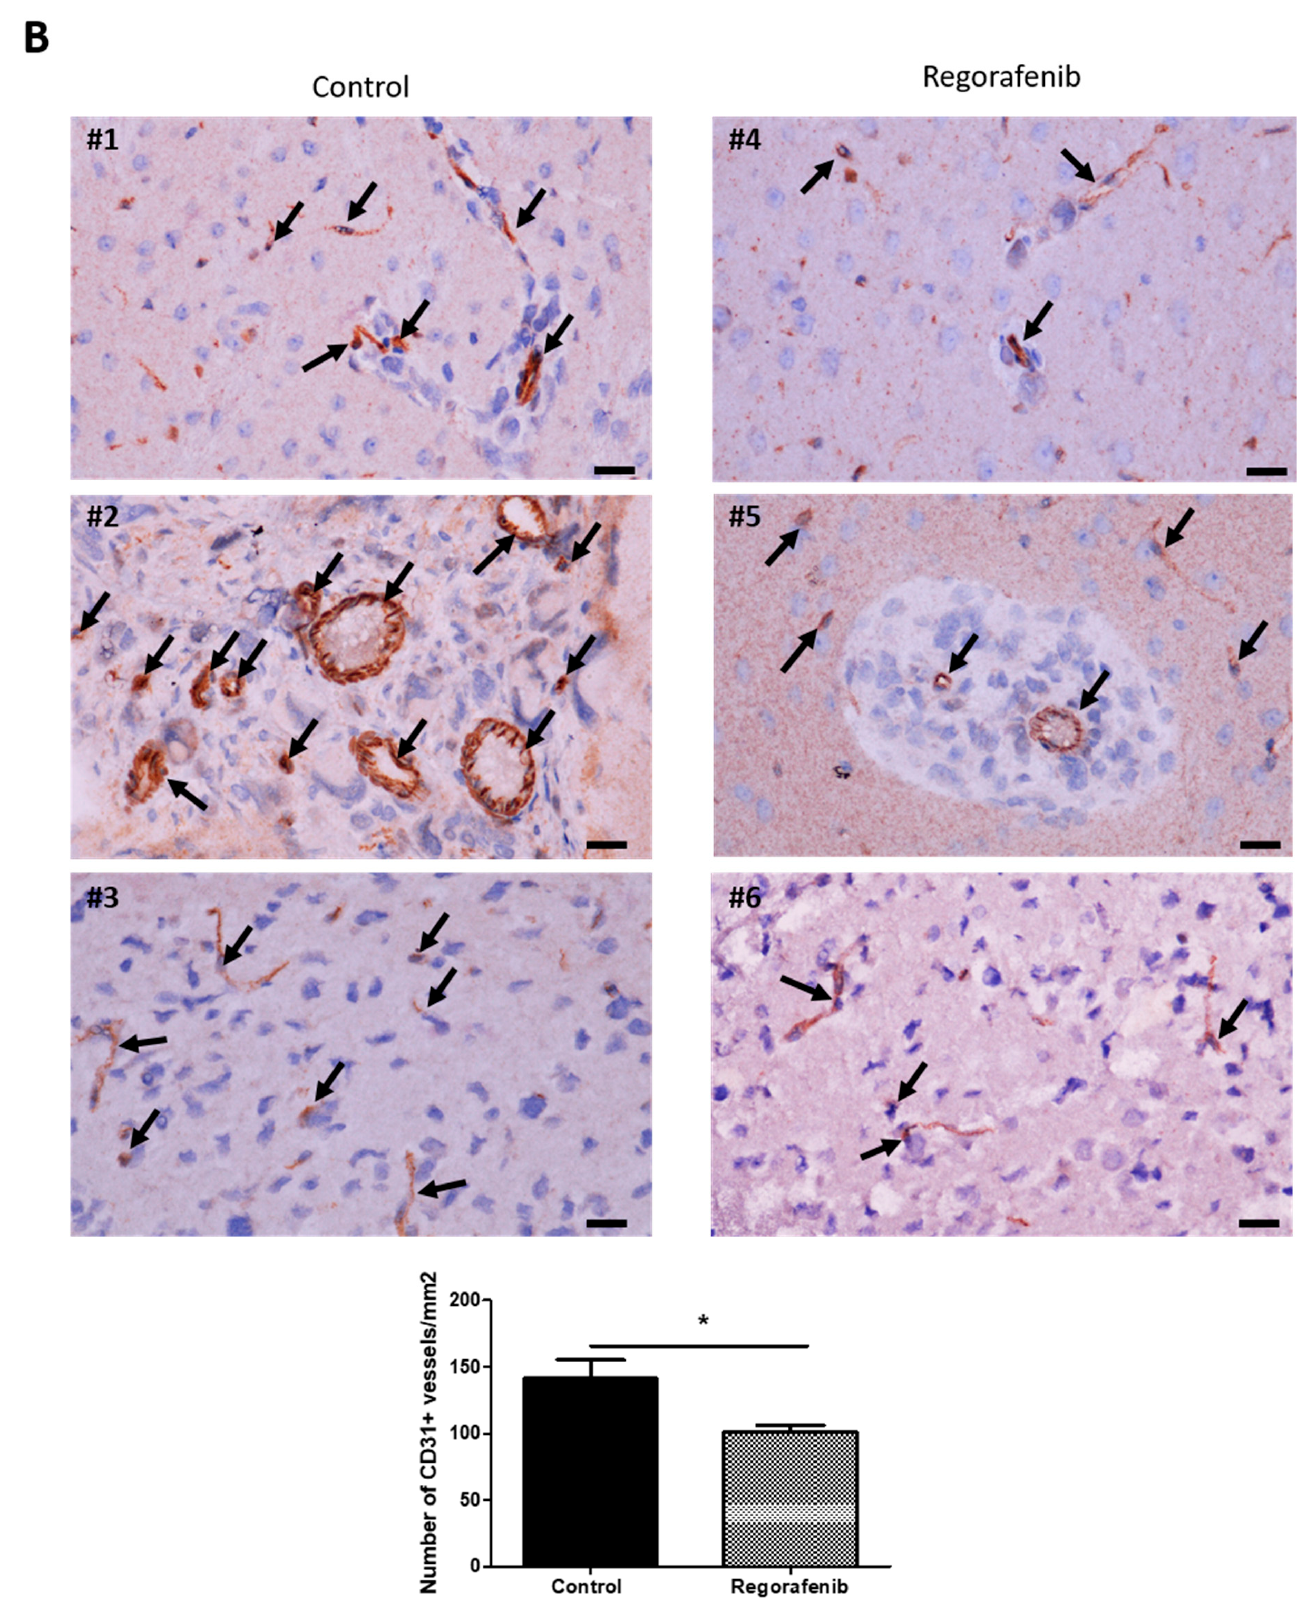
Figure 2. Regorafenib inhibits tumour growth and vascularisation in xenograft mice. GC1 were implanted into the right forebrain of mice. The mice then received daily oral vehicle or regorafenib at 30 mg/kg for 45 days. ( A ) Representative photographs of mice brain tumours treated with regoraf- enib (right panel) or without regorafenib (left panel) stained by hemalun–eosin (median panel) or with nestin antibody (upper and lower panel). The upper panel shows whole brains of mice stained with nestin antibody. The tumour areas were circled in blue, and each surface was measured in mm 2 . The red rectangles indicate the zone of the tumour shown in median (hemalun–eosin staining) and lower (nestin IHC) panel. Scale bars, upper panel 2.5 mm, median and lower panel 100 µm. The graph shows the tumour size in mm 2 (expressed as the mean ± SEM of 4 mice). ( B ) Representative immunohistochemistry photographs of CD31+ vessels in brain tumour areas of 3 different mice